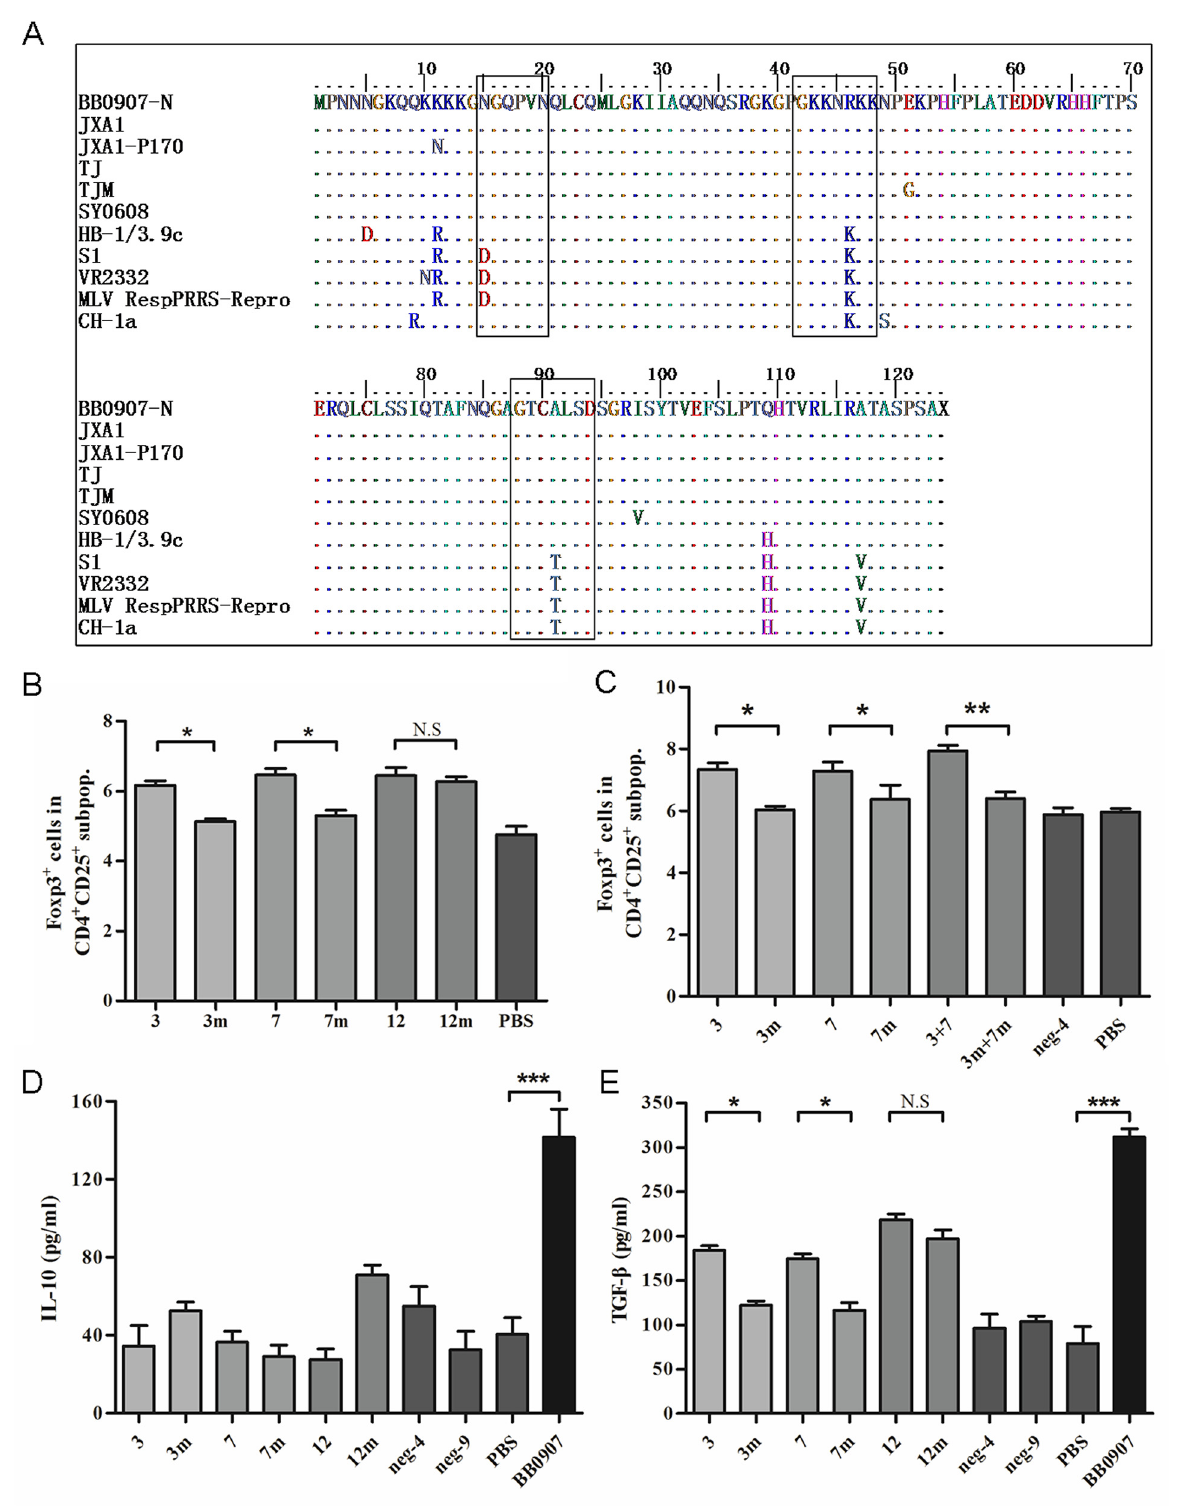
Fig 6. 15N and 46R in HP-PRRSV N protein were key amino acids in Tregs induction. (A) Alignment of amino acid sequences of N protein of PRRSV BB0907, S1 and other representative strains. (B) Percentage of Foxp3 + cells in the gated CD4 + CD25 + subpopulations of three pairs of synthetic peptides. (C)